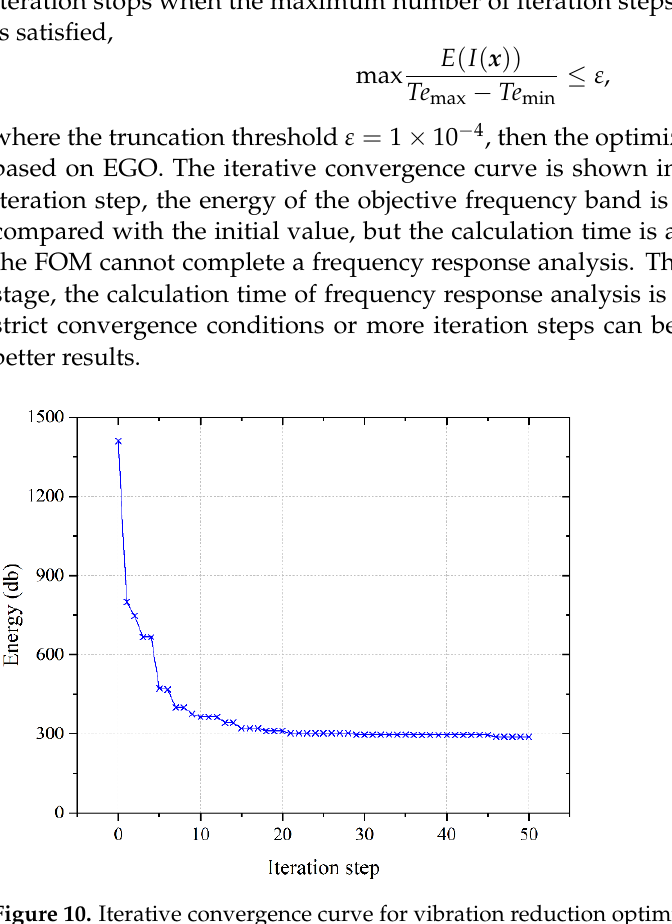
Figure 10. Iterative convergence curve for vibration reduction optimization of the S-shaped curved stiffened shell (ROM).